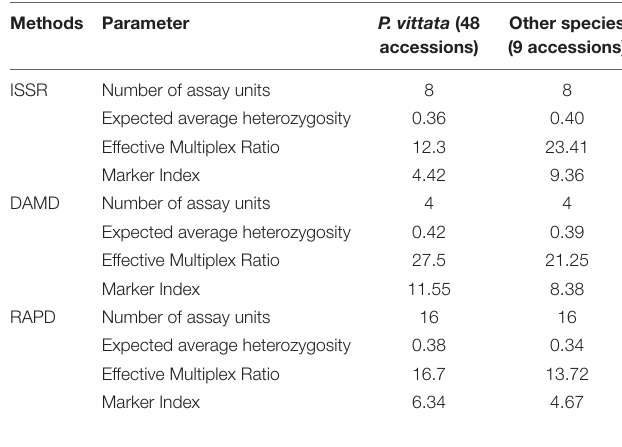
TABLE 4 | Comparison of efficiency of three SPAR methods for 57 genotypes of Pteris